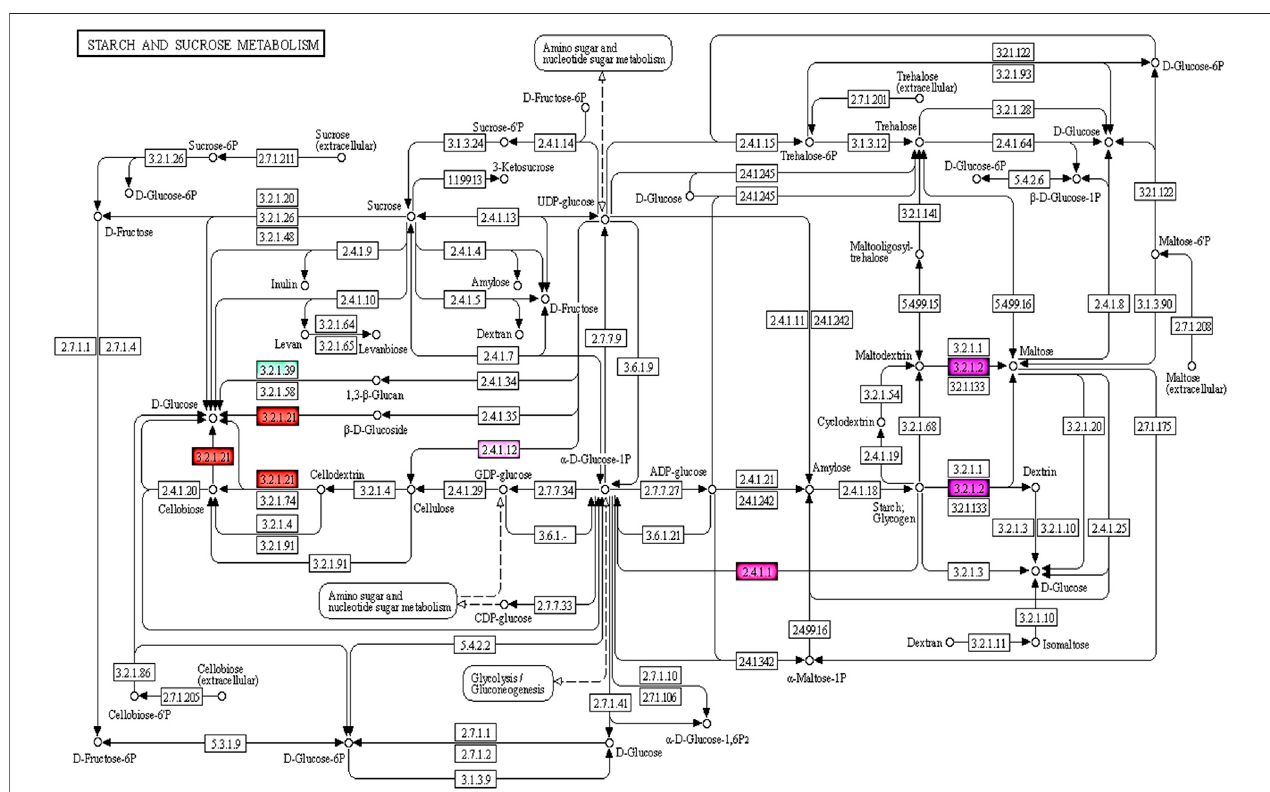
FIGURE 4 | KEGG pathway showing enzymes which are targeted by miRNAs involved in starch and sucrose, amino sugar and nucleotide metabolism of seed development.